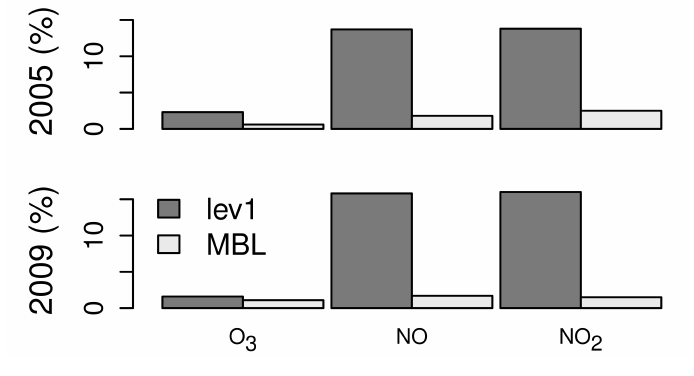
Figure 5. Concentration difference (calculated as Equation (2)) for O first model layer and in the Mediterranean boundary layer